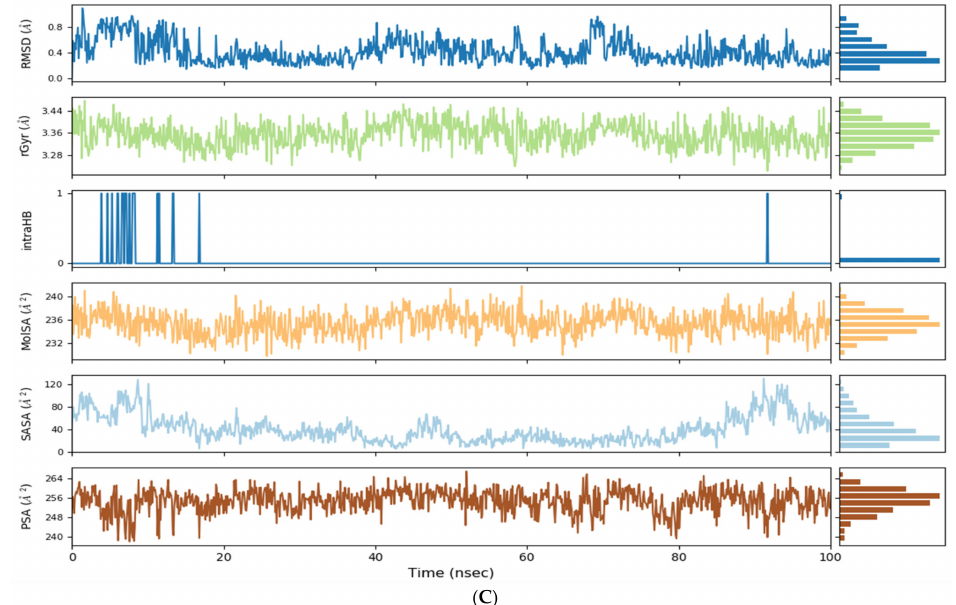
Figure 7. Fludarabine RMSD, rGyr, intramolecular H-bond (intraHB), molecular surface area (MolSA), solvent-accessible surface area (SASA), polar surface area (PSA) calculated during the MD simulation (100 ns). ( A ). A6R, ( B ). D8L, ( C ).